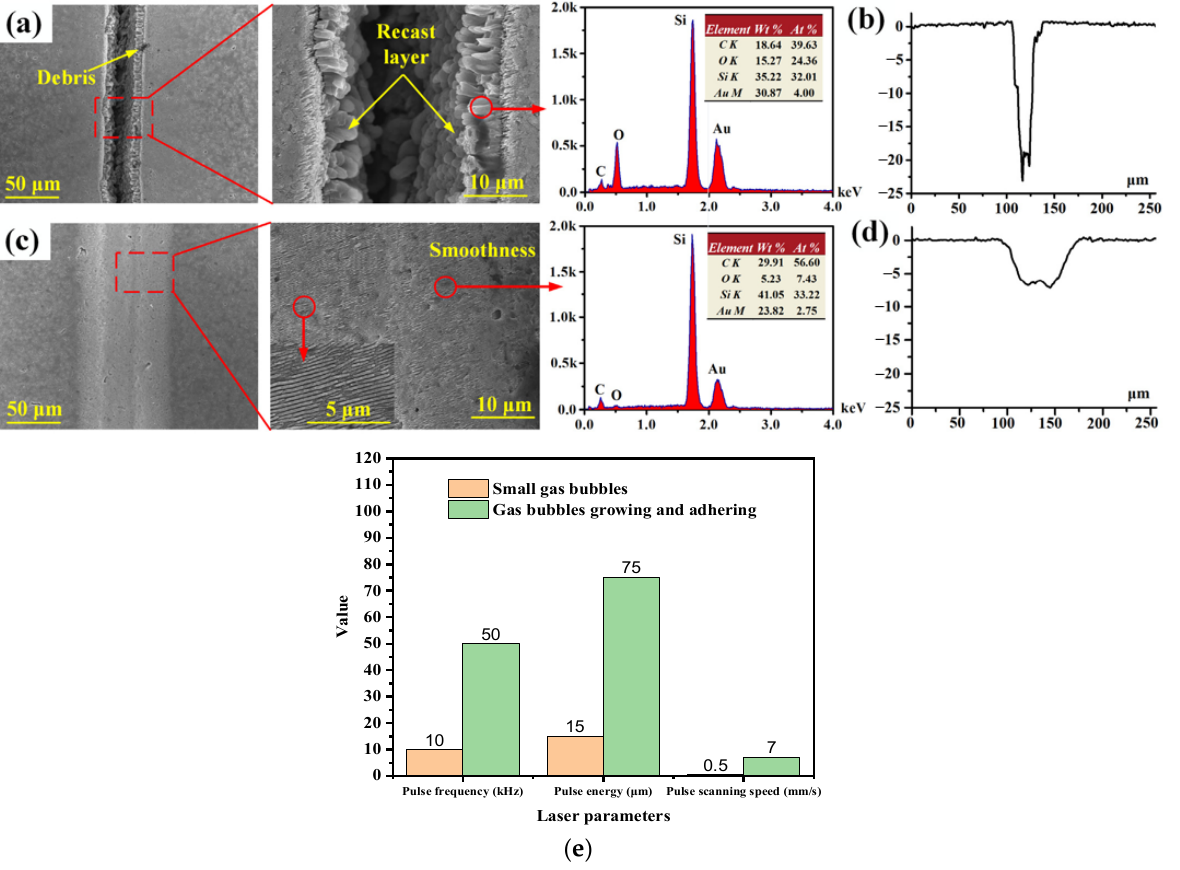
Figure 7. SEM image of generated hole: ( a ) in air; ( c ) in water, micro-pits’ cross-section profile ( b ) in air; ( d ) in water; ( e ) dynamic of bubble generation in underwater processing under various frequencies, pulse energies, and scanning speeds, adapted from [100].